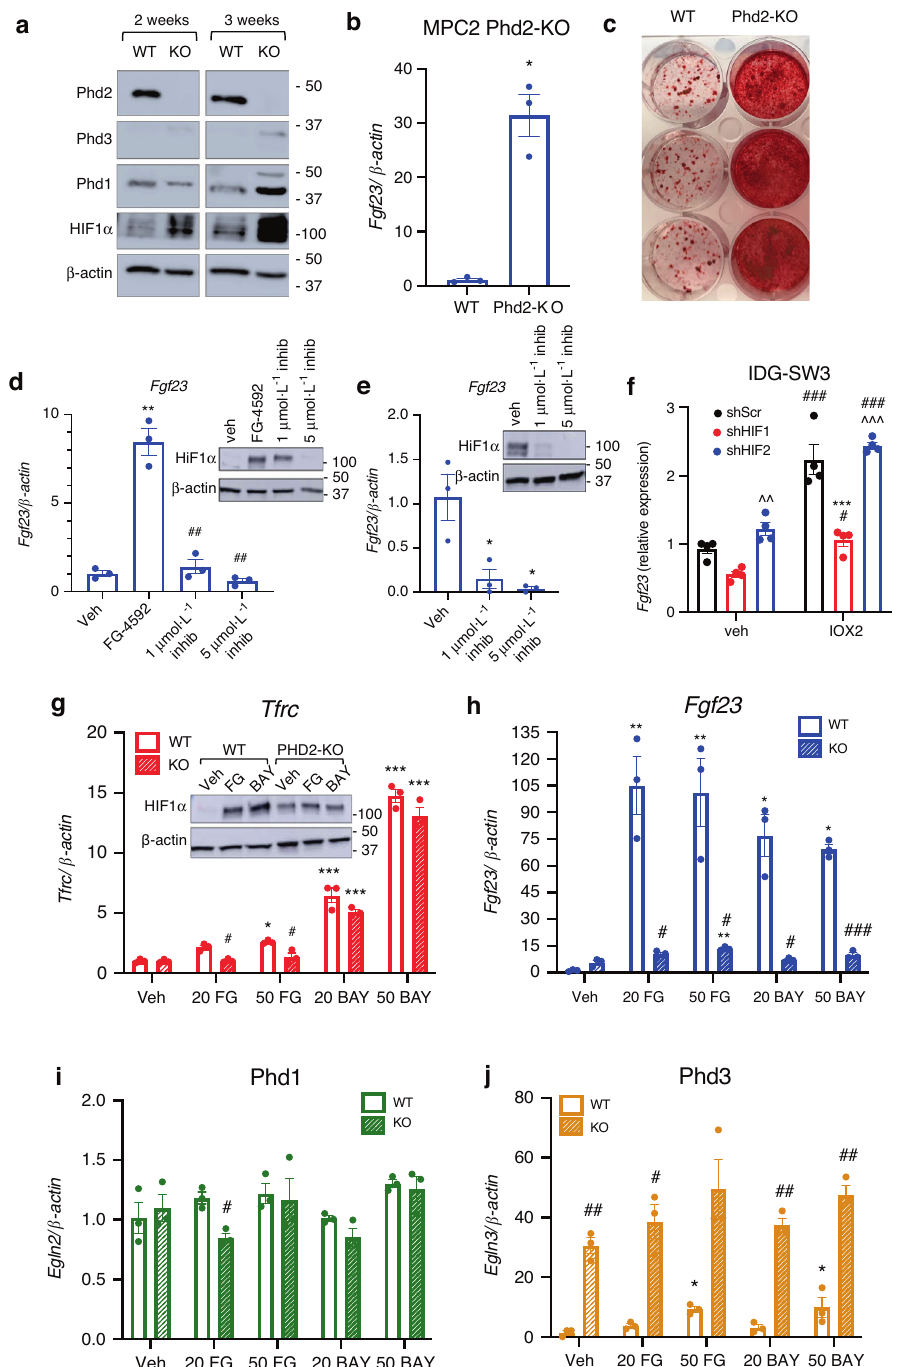
Fig. 4 Phd2 bridges oxygen sensing mechanisms with Fgf23 production. A Phd2-KO cell line was generated in undifferentiated MPC2 cells using CRISPR/Cas9 technology and cells were differentiated for 2 or 3 weeks in osteogenic conditions. a Immunoblot of the Phd isoforms and HIF1 α protein expression in 2- and 3-week differentiated WT and Phd2-KO cells. b Fgf23 expression in 3-week differentiated WT and Phd2-KO MPC2 cells (* P < 0.05 vs. WT cells). c Alizarin red stain to visualize mineral deposition in 3-week differentiated WT and Phd2-KO MPC2 cells. d Fgf23 gene expression and ( D , inset) HIF1 α protein expression in 3-week differentiated WT MPC2 cells treated with the HIF-PHI FG-4592 (Roxadustat) alone or with FG-4592 and 1 μ mol·L − 1 or 5 μ mol·L − 1 of the HIF1 α inhibitor BAY 87-2243 for 48 h (** P < 0.01 versus vehicle; ## P < 0.01 versus FG treatment alone). e Fgf23 expression and (inset) HIF1 α protein expression in 3-week differentiated Phd2-KO cells treated with vehicle (DMSO) or with 1 μ mol·L − 1 or 5 μ mol·L − 1 of the HIF1 α inhibitor BAY 87-2243 for 48 h (* P < 0.05 vs. veh). f Fgf23 expression in IDG- SW3 cells transduced with shRNA against HIF1 α or HIF2 α in vehicle or IOX2-treated cells (*** P < 0.001 vs. Scr control, same treatment, ### P < 0.001 vs. vehicle, same shRNA, ^^^ P < 0.001 shHIF1 vs. shHIF2). g Tfrc , ( g , inset) HIF1 α protein, h Fgf23 , i Phd1, and j Phd3 gene expression in 3-week differentiated WT (solid bars) and Phd2-KO (dashed bars) MPC2 cells treated for 24 h with 20 μ mol·L − 1 or 50 μ mol·L − 1 of the HIF-PHI FG (FG-4592; Roxadustat) or BAY (BAY85-3934; Molidustat) (* P < 0.05, ** P < 0.01, *** P < 0.001 vs. veh, same genotype; # P < 0.05, ### P < 0.001 WT vs. Phd2-KO, same